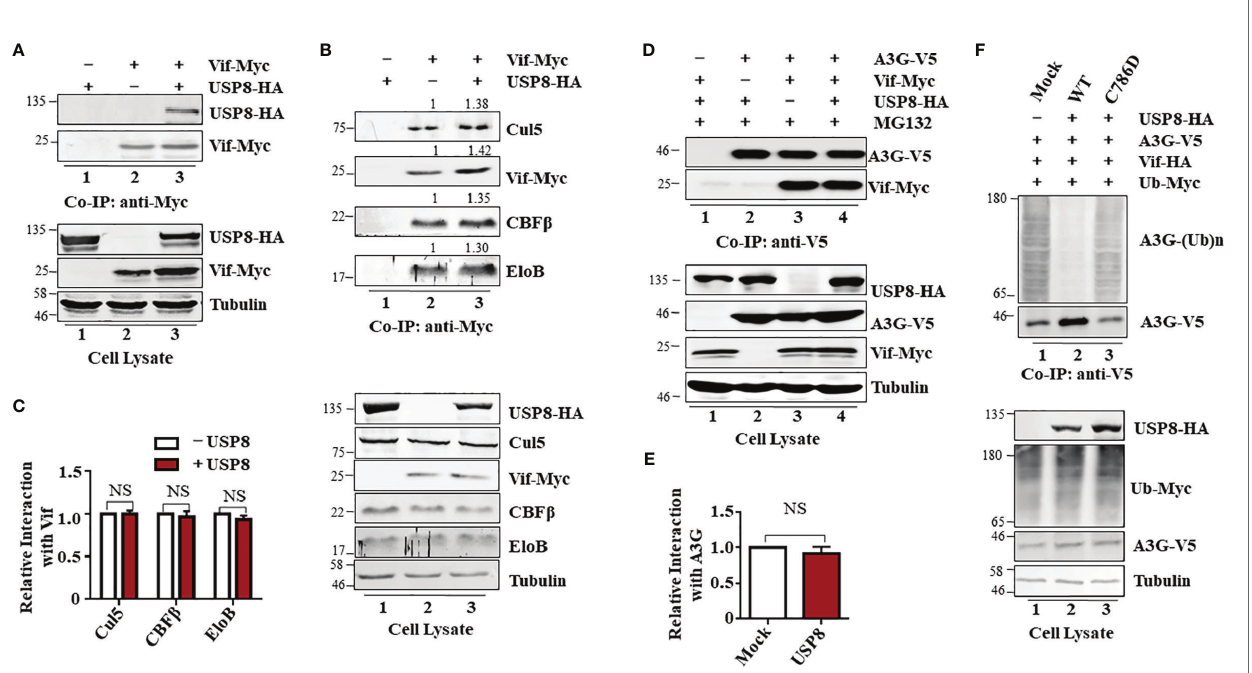
FIGURE 3 | Ubiquitin-speci fi c protease 8 (USP8) speci fi cally interacts with HIV-1 virion infectivity factor (Vif) and reduces Vif-triggered apolipoprotein B mRNA-editing enzyme catalytic polypeptide-like 3 (APOBEC3)G (A3G) polyubiquitination. (A) Co-precipitation of USP8 with Vif. HEK293T cells were transfected with USP8-HA, Vif- Myc alone, or both, as indicated. Cell lysates were prepared and immunoprecipitated using anti-Myc antibody conjugated to agarose beads 48 h after transfection. Cell lysates and precipitated samples were separated by sodium dodecyl sulfate – polyacrylamide gel electrophoresis (SDS-PAGE), transferred to nitrocellulose membranes, and reacted with an anti-HA antibody to detect USP8-HA and an anti-Myc antibody to detect Vif-Myc. Tubulin was used as the loading control for the cell lysate. (B) USP8 does not affect Vif – CRL5 E3 ubiquitin ligase formation. HEK293T cells were transfected with Vif-Myc, USP8-HA, or both. Cell lysates were immunoprecipitated with anti-Myc antibodies conjugated to agarose beads. Cell lysates and precipitated samples were analyzed by immunoblotting with the corresponding antibodies. Tubulin was used as the loading control for the cell lysate. (C) Relative binding ability of Vif with Cul5, CBF b , and EloB in the presence or absence of USP8 was determined by ImageJ2X. Protein binding to Vif in lane 2 (B , upper blots ) was set to 1.0. Data are means ± SD from n = 3 independent experiments. The statistical signi fi cance analyses were performed using two-sided unpaired t-tests (NS, not signi fi cant). (D) The association of Vif with A3G is also not affected by USP8. HEK293T cells were co-transfected with expression vectors as indicated. Cells were treated with 10 mM MG132 12 h before harvesting. Vif protein was immunoprecipitated from cell lysates with an anti-V5 antibody conjugated to agarose beads. Cell lysates and precipitated samples were analyzed by immunoblotting with the corresponding antibodies. Tubulin was used as the loading control for the cell lysate. (E) Quanti fi cation of co-precipitated Vif relative to A3G was determined by ImageJ2X. Data are means ± SD from n = 3 independent experiments. The statistical signi fi cance analyses were performed using two-sided unpaired t-tests (NS, not signi fi cant). (F) USP8 inhibits Vif-triggered polyubiquitination of A3G. HEK293T cells were transfected with the empty vector, Vif-HA, A3G-V5, Ub-Myc, or USP8-HA as indicated. Cells were treated with 10 mM MG132 for 12 h before harvesting. Cell lysates were prepared and immunoprecipitated using anti- V5 antibody conjugated to agarose beads 48 h after transfection. Cell lysates and precipitated samples were analyzed by immunoblotting with the corresponding antibodies. Immunoblotting results from panels (A, B, D, F) are representative of n = 3 independent